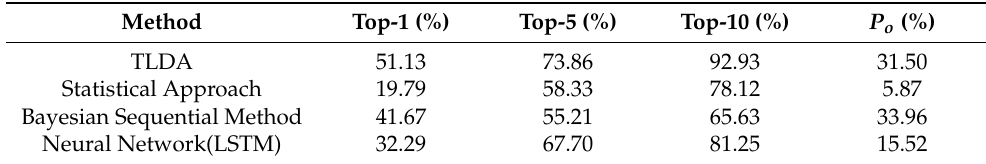
Table 4. Performance comparison with different